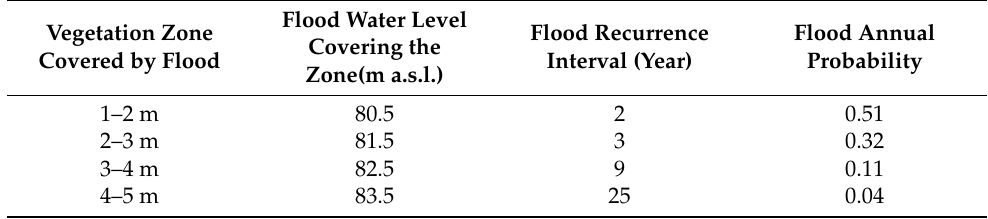
Table 4. Recurrence interval and annual probability of floods submerging the vegetation height zones up to the level of the artificial